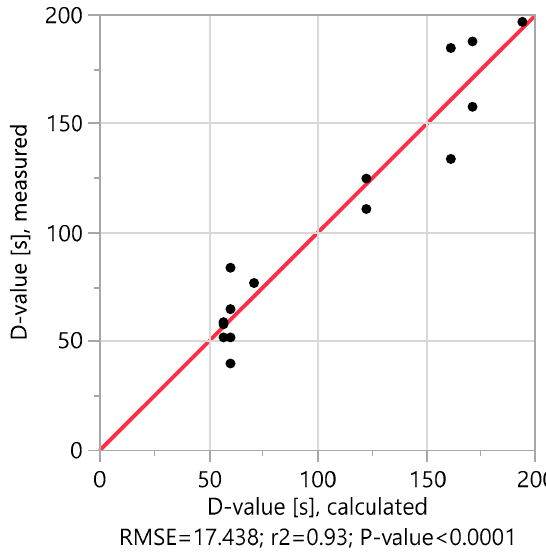
Figure 1. Observed values versus prediction. The diagram shows the actual measured D-values compared to the predicted calculated D-values. For a good approximation, the points on the scatter diagram must move to the red line. The points are all very close to the line, which means that the model maps the dependencies very well. Another indicator of model accuracy is the r 2 value. This measures the percentage of variability in the D-value that is explained by the model. A value closer to 1 means that the model gives a good forecast (in this case, 0.93).